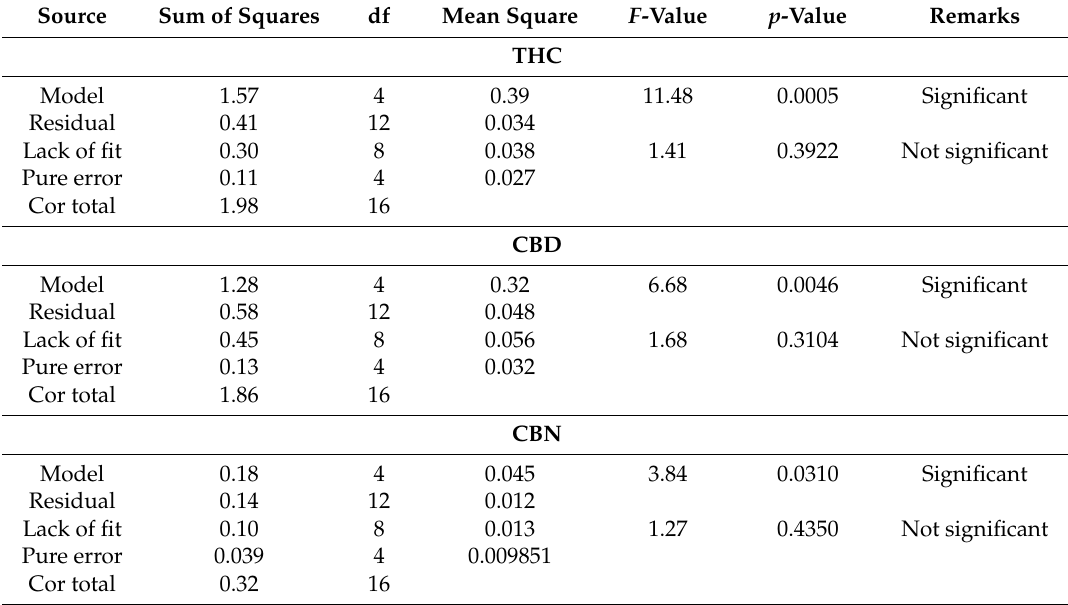
Table 2. Analysis of variance of reduced quadratic model for extraction yields of three